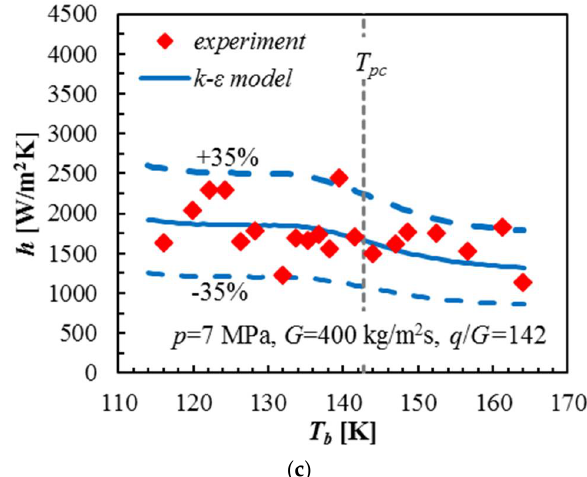
Figure 6. Comparisons of LHTCs between experimental results and simulation results with k - ε model for various values of q / G (Unit: J/kg) at p = 7 MPa and T in = 110 K: ( a ) q / G = 75; ( b ) q / G = 118; and ( c ) q / G = 142. The blue dash lines represent ± 35% deviations with respect to the blue solid line (i.e., simulation results).